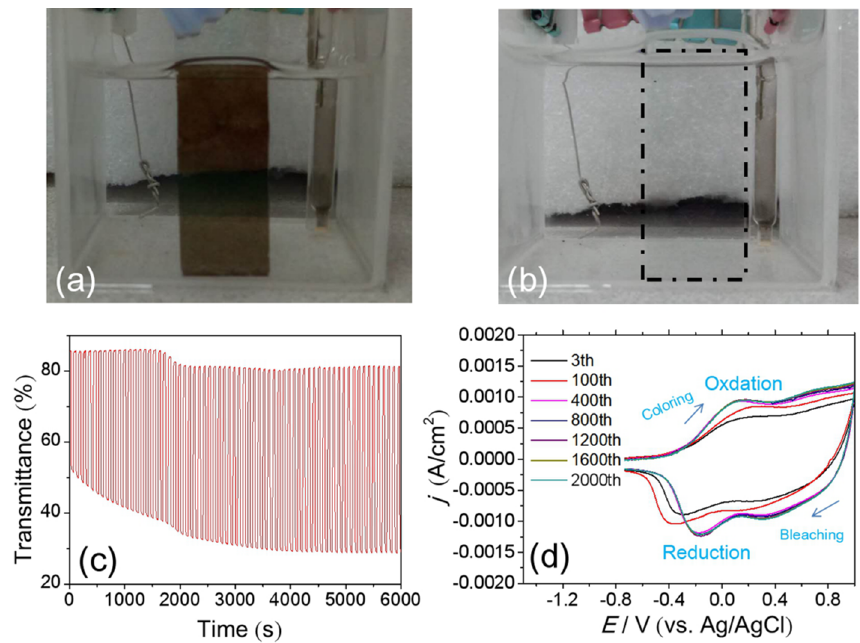
Figure 11. ( a ) Optical images of the colored and bleached states; ( b ) Optical images of the colored and bleached states; ( c ) cycles of optical switching for the optimized sample in 1 M KOH electrolyte and ( d ) CVs of the optimized NiO x film in 0.5 M LiClO 4 -PC electrolyte.